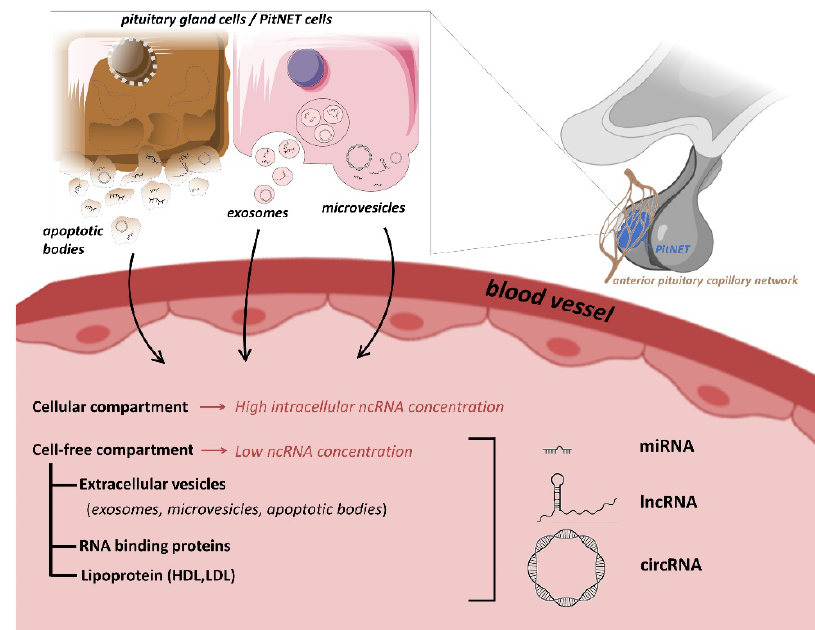
Figure 1. Potential origin and type of ncRNAs as biomarkers in PitNET.